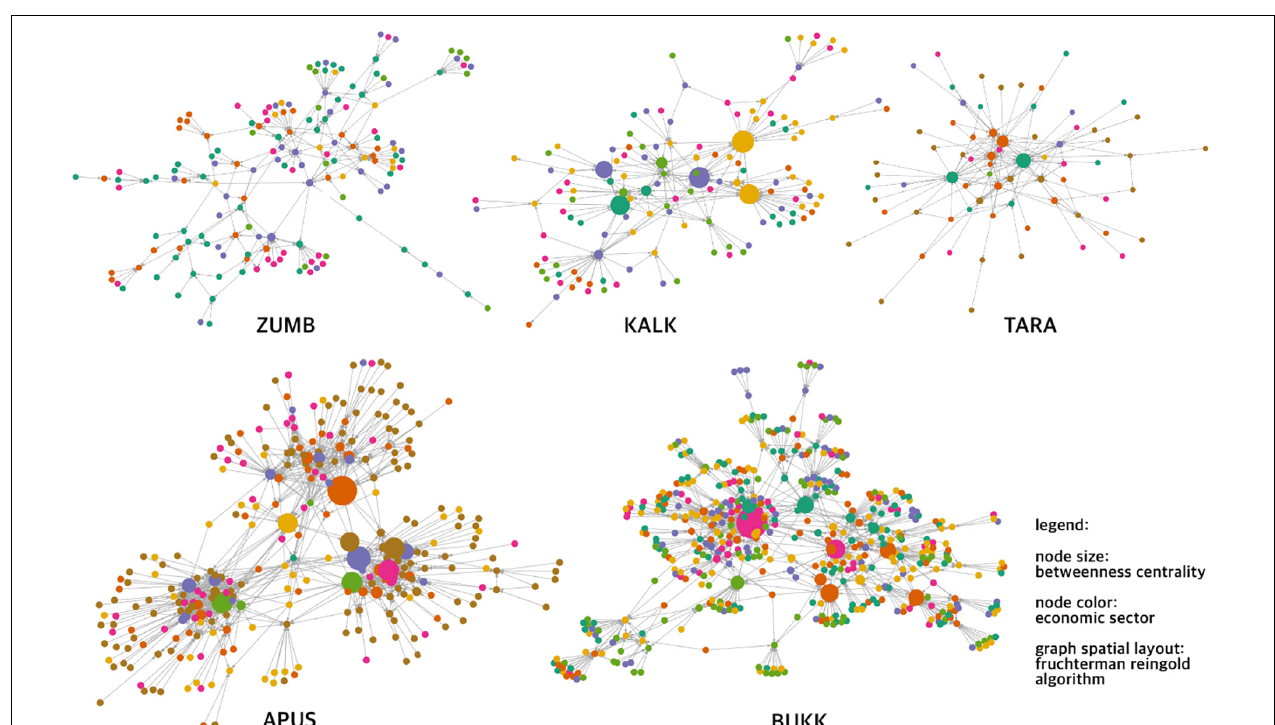
FIGURE 3 | Social network graphs of the 5 study